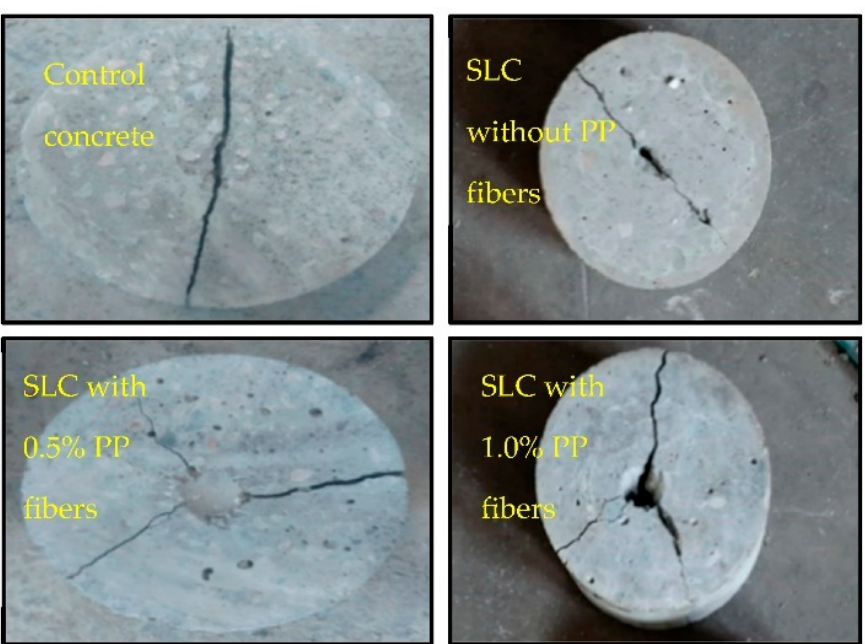
Figure 11. Failed concrete disk specimens in drop weight impact test.